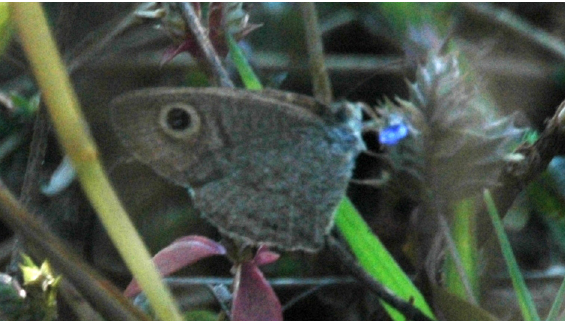
Image 13. Lesser Three Ring Ypthima inica (dry season form - February)